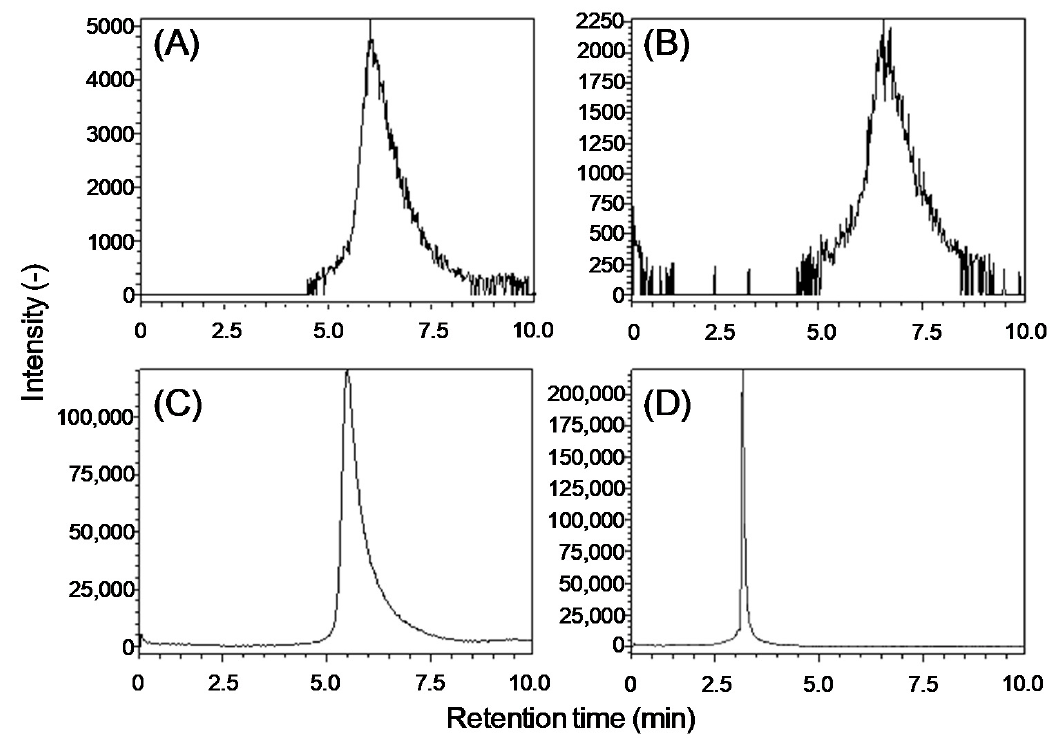
Figure 1. Optimization of reverse-phase LC-MS solvent conditions. Extracted-ion chromatogram of 5 µ M of E. coli lipid A standard ( m / z = 1796.211). Solvents A and B consisted of a 9:1 ( v / v ) methanol:water mixture and 100% 2-propanol, respectively, supplemented with ( A ) 10 mM of ammonium acetate, ( B ) 100 mM of ammonium acetate, ( C ) 10 mM of ammonia, or ( D ) 100 mM of ammonia.